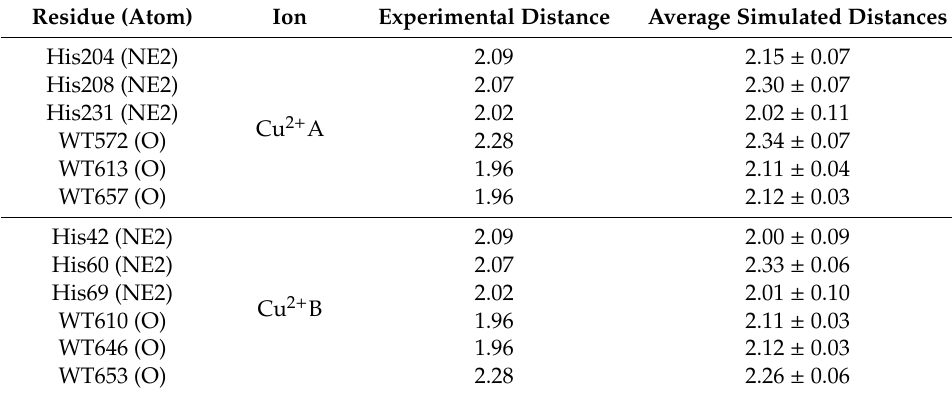
Table 3. Experimental and average simulated distances (in Å) between His residues (or water molecules) and copper ions (Cu 2 + A and Cu 2 + B) in the TYR Bm -KA system. The experimental distances for His residues were taken from the crystal structure (Protein Data Bank (PDB) code: 5I38) [45]. For the water molecules, the experimental values are 1.96 and 2.28 Å for water molecules in the equatorial and axial positions, respectively